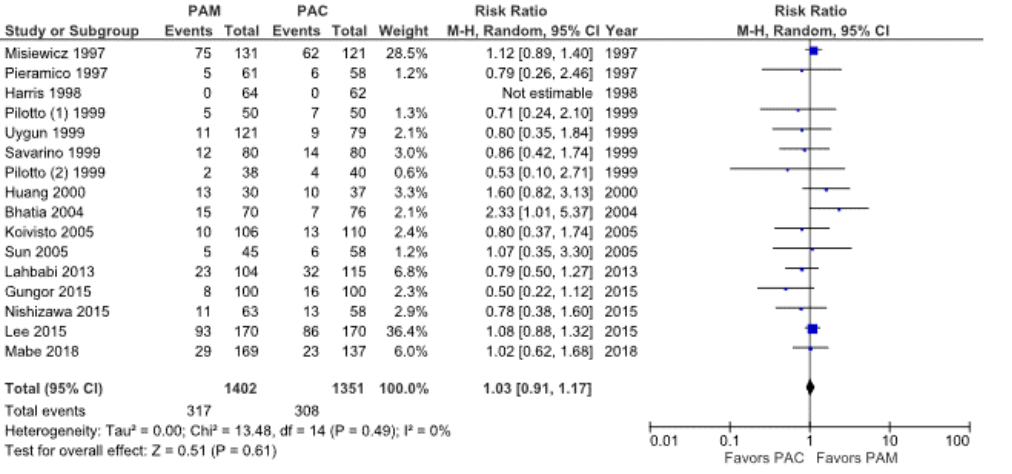
Figure 6. ( A ) Forest plot and ( B ) funnel plots of the incidence rate of all adverse events between PAC Figure 6. Forest plot of the incidence rate of all adverse events between PAC therapy and PAM therapy therapy and PAM therapy in the random-effects model. Abbreviation: CI, confidence interval; PAC, in the random e ff ects model. Abbreviation: CI, confidence interval; PAC, proton pump inhibitor proton pup inhibitor (PPI)/amoxicillin/clarithromycin; PAM, PPI/amoxicillin/ metronidazole. (PPI) / amoxicillin / clarithromycin; PAM, PPI / amoxicillin / metronidazole. The incidence rate of diarrhea was similar between PAC therapy (8.9%, 144 / 1623, 95%